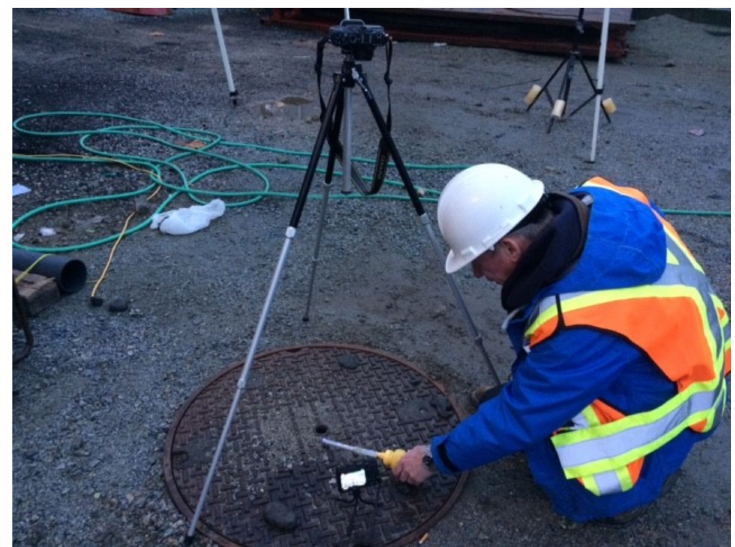
Figure 3. Technique for providing “smoke” near the opening in the manhole cover. All but the center opening were plugged. The photo also shows configurations of the cameras during experimentation to determine the optimum position for capturing video along the surface of the ground. (A low oblique angle as shown in the lower camera produced the best